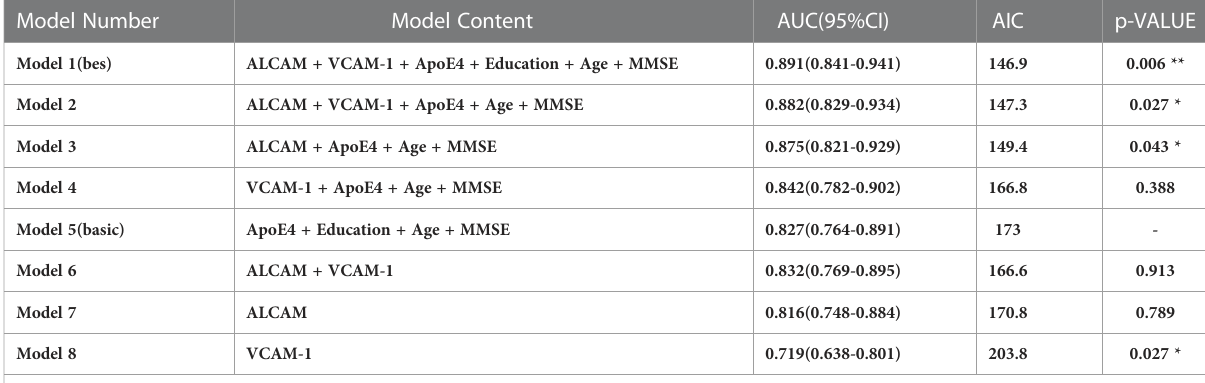
TABLE 2 Parameters of each model under two-way stepwise logistic regression: Area under curve (AUC), Akaike information criterion (AIC), and the P value of statistical difference compared with Model 5 (p-VALUE). Model Number